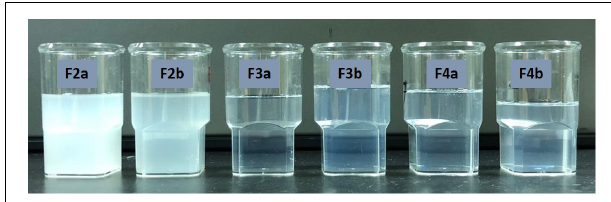
FIGURE 1 | Typical physical appearance of immediately dispersed formulations. The formulation used in the experiment were aqueous dispersions of the “drug free” formulations F2–F4 representing the most efficient self-nanoemulsifying systems